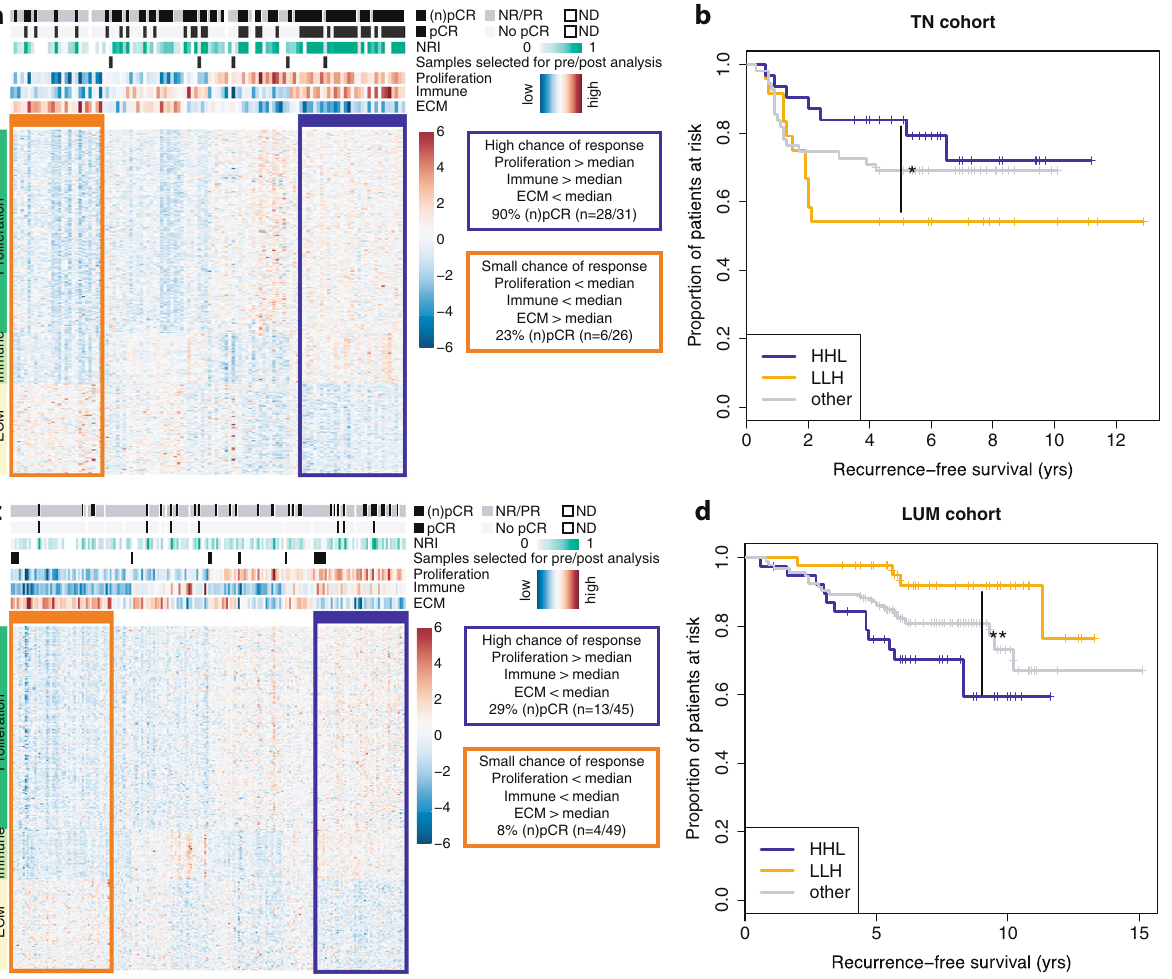
Fig. 1 Biological processes associated with response to neoadjuvant chemotherapy. a Heatmap of expression levels of genes associated with response to neoadjuvant chemotherapy in triple negative breast cancer patients. Cases are in columns, genes in rows. Biological processes associated with the genes in this heatmap are indicated on the left; patient and sample information are indicated on the top: top track indicates treatment response in the breast; second and third tracks indicate treatment response in the breast and lymph nodes. The three bottom tracks indicate the average gene expression level of the genes associated with proliferation, immune response and ECM. The orange and blue boxes respectively indicate the gene expression pro fi les of poor and good responders. Black bars at the bottom indicate which samples were included in the pre/post chemotherapy analyses. ECM extracellular matrix, ND not determined, (n)pCR (near) pathological complete response, NRI neoadjuvant response index. b Kaplan – Meier curves showing recurrence-free survival in subgroups of triple negative patients as identi fi ed in ( a ). HHL (blue) High proliferation, High immune response, Low ECM, LLH (orange) Low proliferation, Low immune response, High ECM, and other combinations (gray). c Heatmap of expression levels of genes associated with response to neoadjuvant chemotherapy in ER + /HER2 − breast cancer patients. Format is the same as in ( a ). d Kaplan – Meier curves showing recurrence-free survival in subgroups of ER + /HER2 − patients as identi fi ed in ( c ). * p < 0.05; ** p < 0.01 (Kaplan – Meier and an ‘ other ’ group. We then assessed progression-free survival indicative of highly proliferative tumor cells. The highest response rates in the three subgroups. Using all samples, a similar trend as rates were observed for TN patients that showed high expression observed in the neoadjuvant cohort was visible, but not signi fi cant of both proliferation and immune response genes, and low (Supplementary Fig. 4A, p = 0.2). We subsequently performed expression of ECM genes (Proliferation = H, Immune = H, ECM = L, analyses strati fi ed for clinical subgroups in the TCGA basal cohort, denoted as ‘ HHL ’ ). In contrast, patients at the other end of the de fi ned as high-risk (lymph-node positive (N + ) or T-stage 3/4) spectrum (Proliferation = L, Immune = L, ECM = H, denoted as ‘ LLH ’ ) showed the lowest response rates (measured as ( n )pCR, p < (Supplementary Fig. 4B), lymph-node negatve versus positive (Supplementary Fig. 4C, D), and T-stage 1/2 versus T-stage 3/4 0.001). In line with this observation, HHL-patients showed (Supplementary Fig. 4E, F). In high-risk patients and in N + signi fi cantly higher 5-year recurrence-free survival rates, compared patients, HHL-patients show signi fi cantly higher progression-free to the LLH group ( p = 0.02, HR 0.29 (95%CI 0.10 – 0.85), Fig. 1b). survival rates compared to LLH- and other patients ( P = 0.02 and Patients who could not be strati fi ed in either the LLH or HHL P = 0.004, respectively), while in node negative and T-stage 1/ 2, group (denoted hereafter as ‘ other ’ ) showed intermediate no differences in survival rates were observed. response and survival rates. We then tested whether the genes identi fi ed in TN tumors also To investigate the value of this strati fi cation method in an have predictive power in ER + breast cancer: 62 genes from the independent cohort, we strati fi ed basal breast cancer patient core enrichment set were associated with (near) pCR in ER + samples from the TCGA PanCancer cohort 19 into an ‘ HHL ’ , an ‘ LLH ’